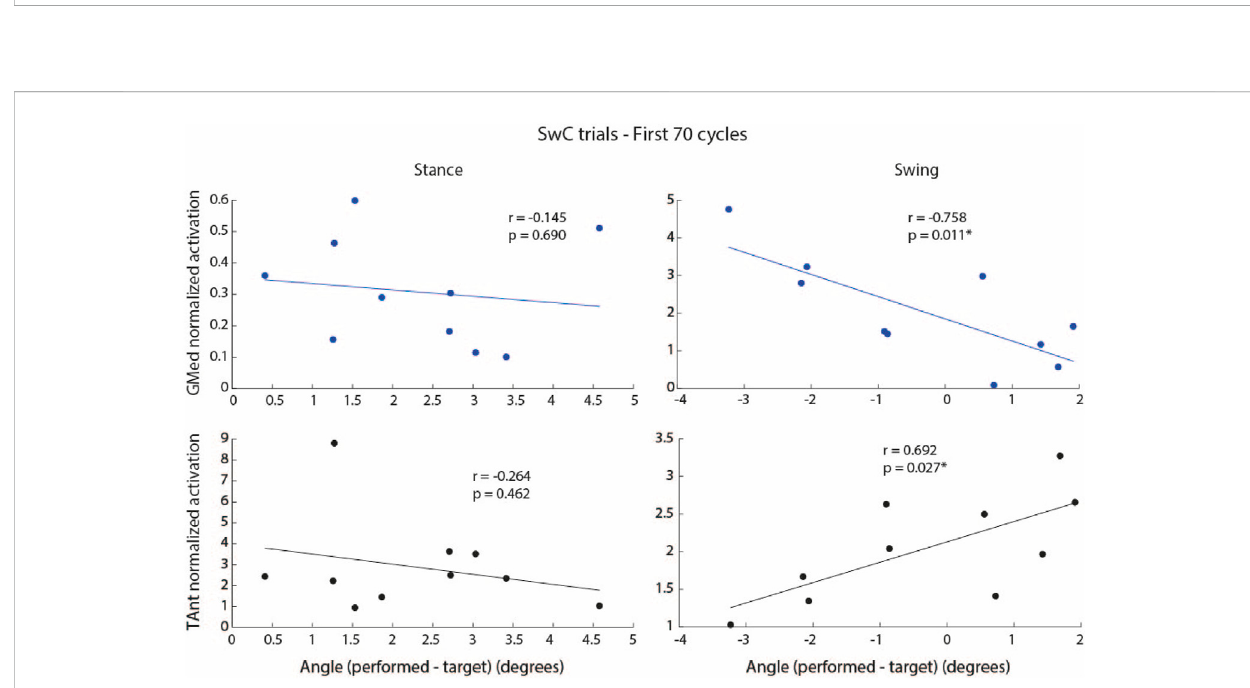
FIGURE 11 Correlation between integrated EMG activity of GMed (blue dots and regression lines) and TAnt (black dots and regression lines) and the error (mathematical subtraction) between maximum performed ankle angle and maximum target angle for stance and swing phases during the fi rst 70 cycles of SwC trials. Each dot represents each subject. p <